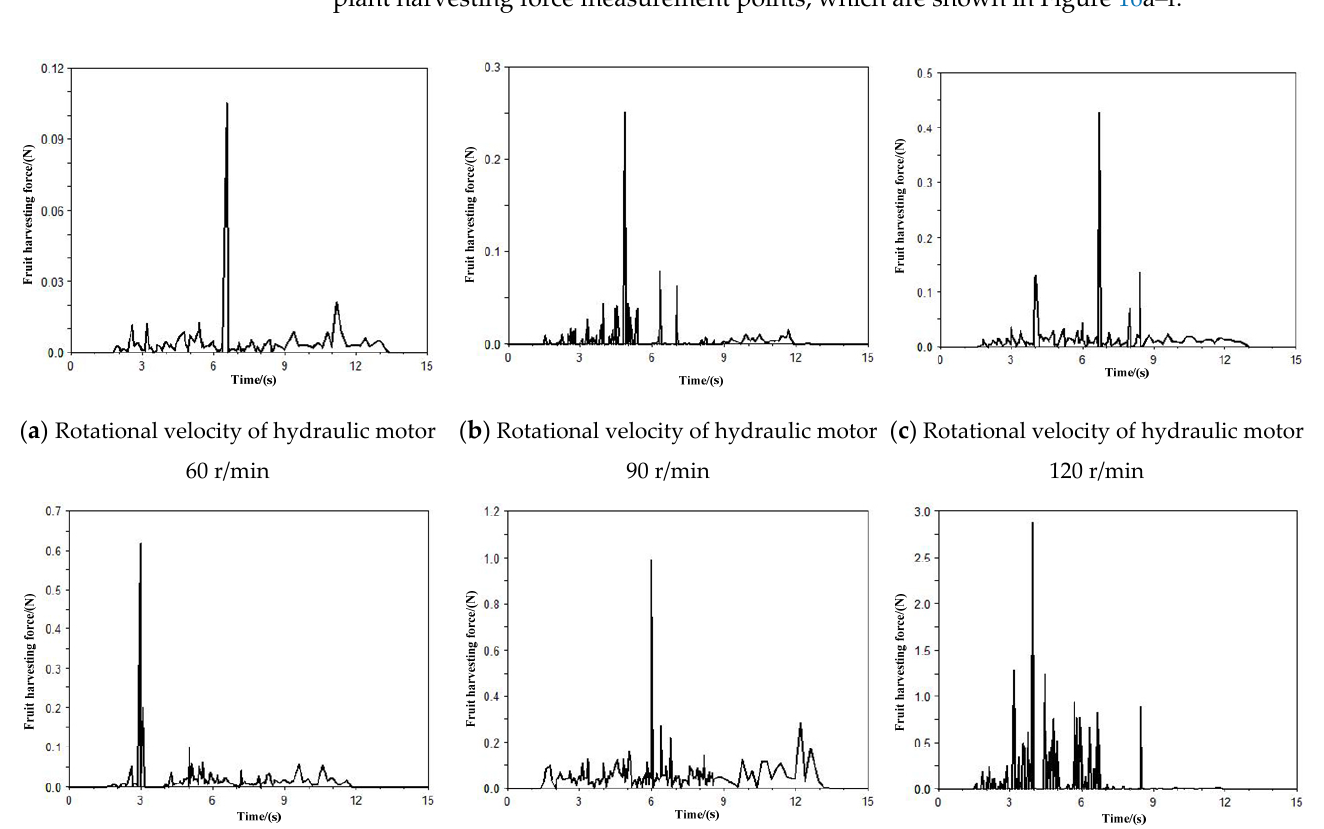
( f ) Rotational velocity of hydraulic motor 210 r/min Figure 15. Analysis of the influence of rotational velocity on the harvesting collision force. It can be seen from Figure 15 that with a continuous increase in the output rotational velocity of the hydraulic motor of the harvesting system, the transient collision force 𝐹⃗ (cid:3036) (𝑡) at the measurement point also increased, due to the fact that the increase in rotational